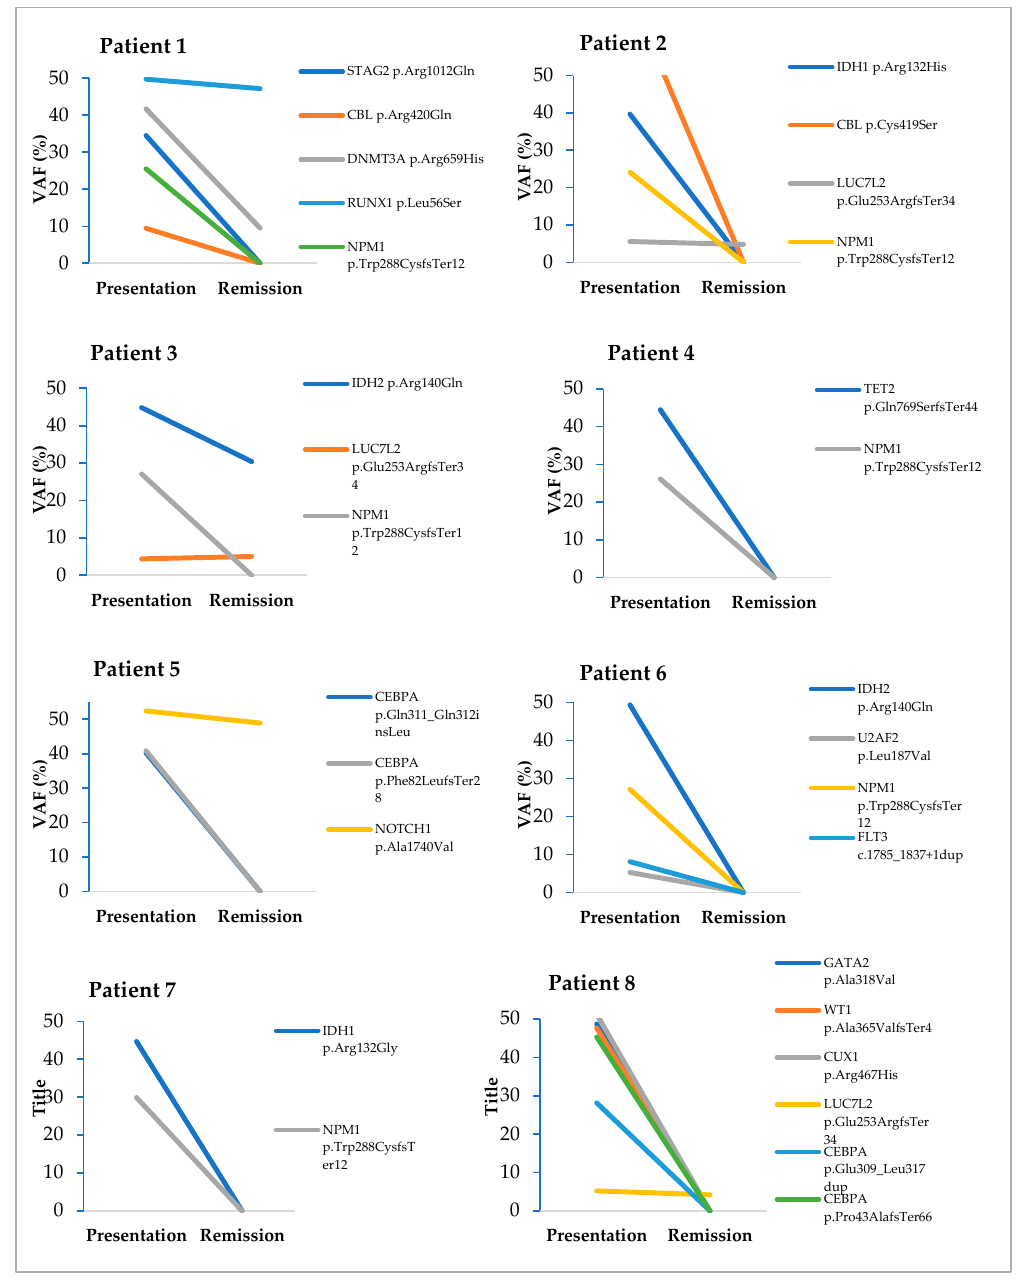
Figure 2. Comparison between VAFs during disease presentation and after CR1/CR2. Each line in the graph corresponds to a somatic pathogenic variant detected during disease presentation and after CR1/CR2. Only pathogenic variants were included in each patient’s VAF comparison during the presentation and after CR1/CR2.